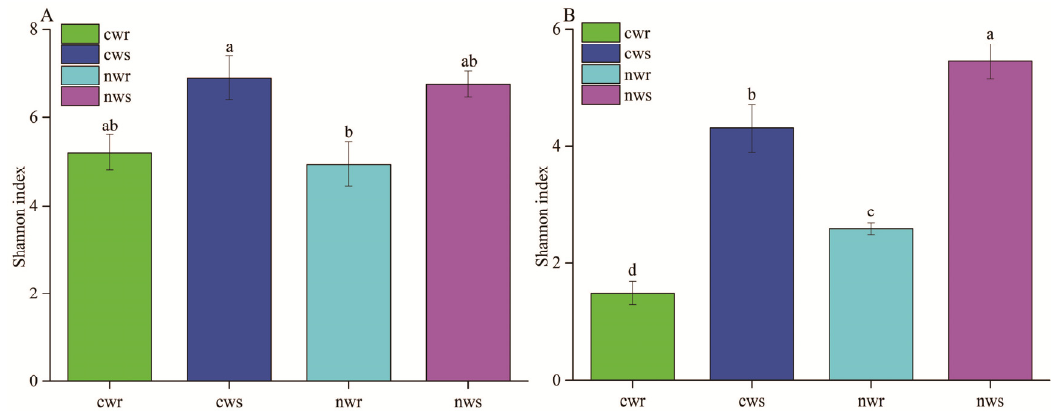
Figure 3. Shannon diversity indices of ( A ) bacterial and ( B ) fungal communities in the rhizosphere and root endosphere of naturally grown and cultivated trees. Different lowercase letters on each column represent significant differences ( p < 0.05) between the rhizosphere and root endosphere based on the least significant difference test. cwr—cultivated tree endosphere; cws—cultivated tree rhizosphere; nwr—naturally grown tree endosphere; nws—naturally grown tree rhizosphere.